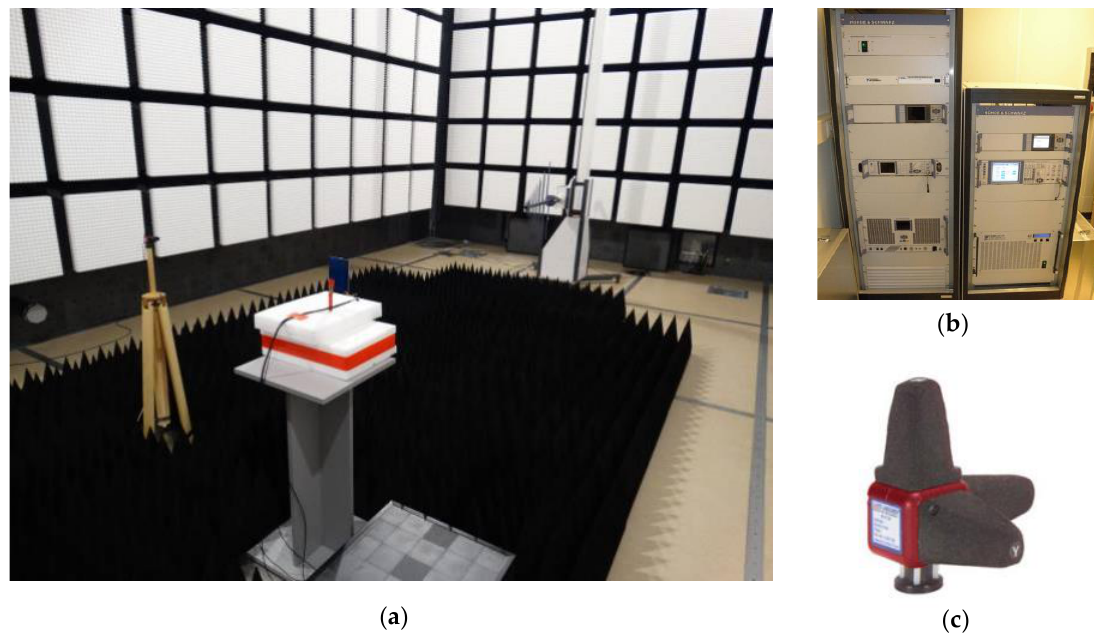
Figure 13. Verification stand ( a ) Test bed to analyze strength of the electromagnetic field in anechoic chamber TDK; ( b ) HI6005 Probe; ( c ) Generator and amplifier systems for generating electromagnetic waves in the range of up to 1 GHz and from 1 to 6 GHz.